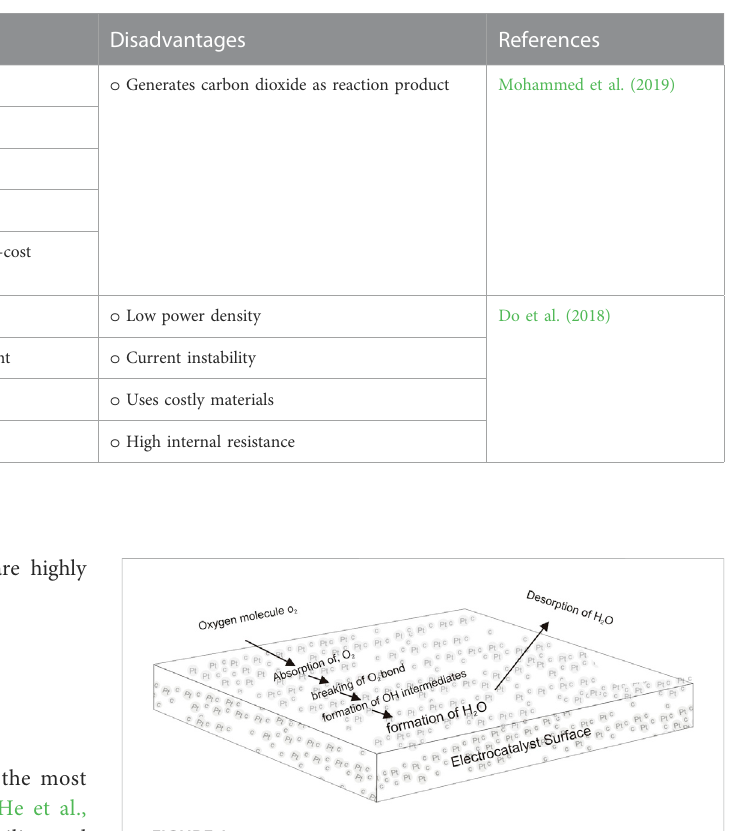
FIGURE 1 Schematic representation of electrocatalyst